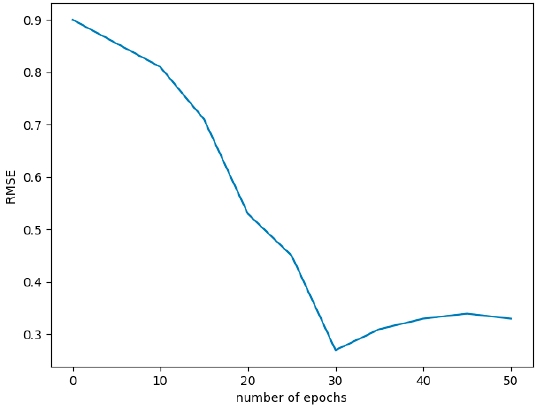
Figure 3. Decrease in RMSE for Intensified LSTM. Atmosphere 2019 , 10 , x FOR PEER REVIEW